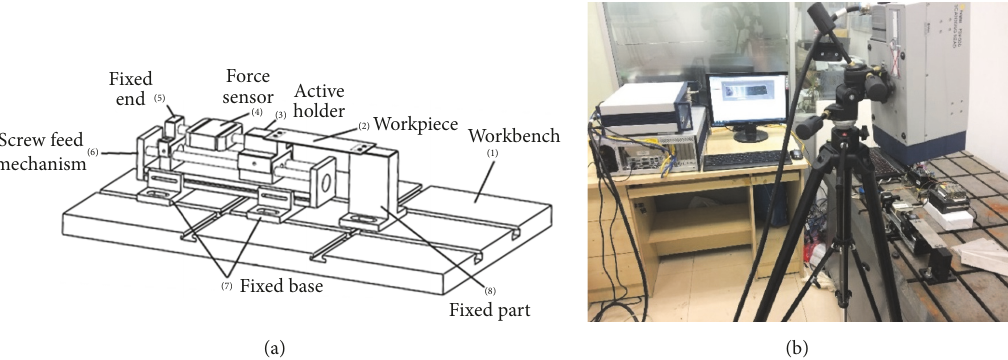
Figure 5: (a) Comprehensive experiment platform. (b) Comprehensive test experiment platform and scanning laser vibrometer.